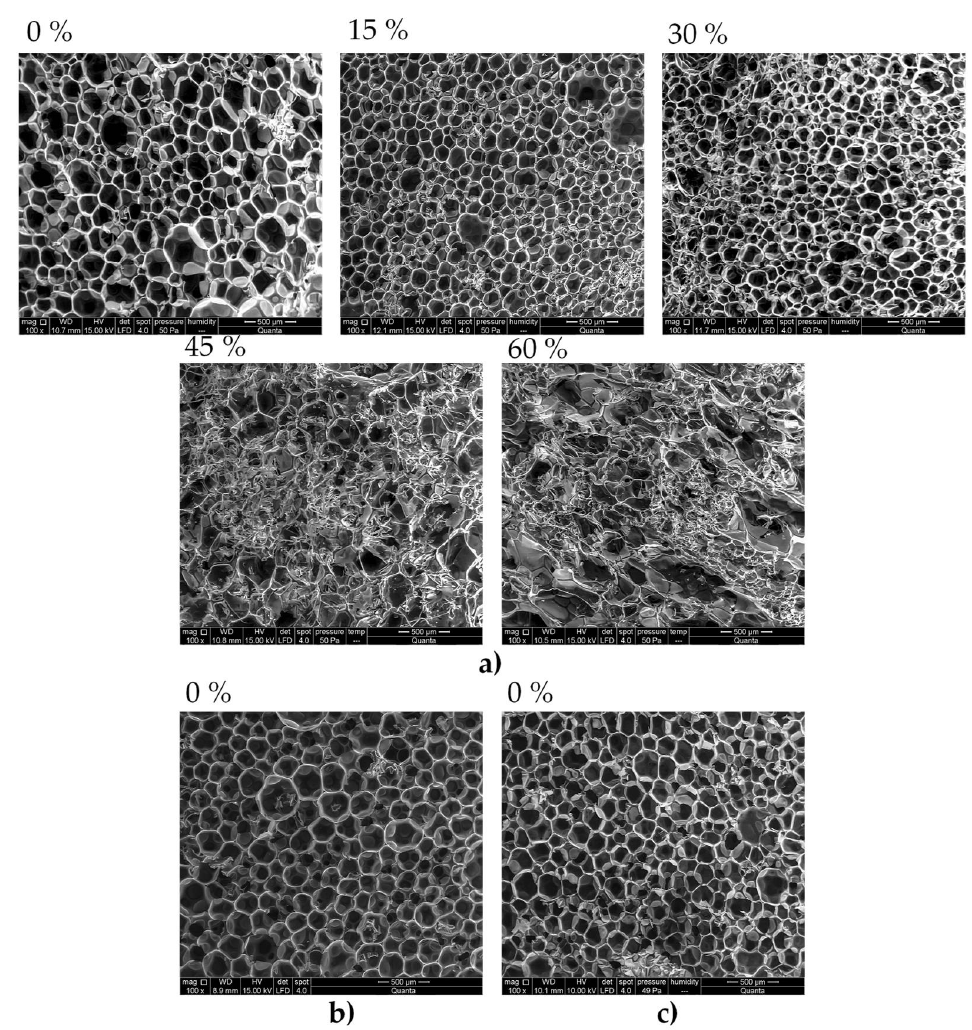
Figure 11. SEM micrographs with magnification ×100 of the PU foams with different proportions of recovered polyols with recovered nanosilica ( a ) and 0% recovered polyol with fresh nanosilica ( b ) and without nanosilica ( c ). ( b ) and without nanosilica ( c